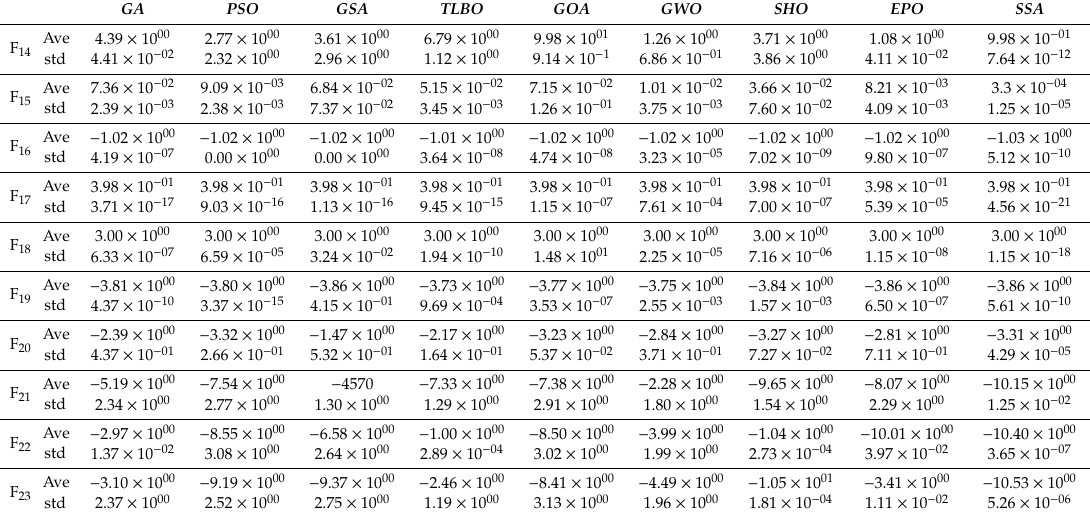
Table 3. Results for SSA and other algorithms in Multimodal test functions with low dimension.